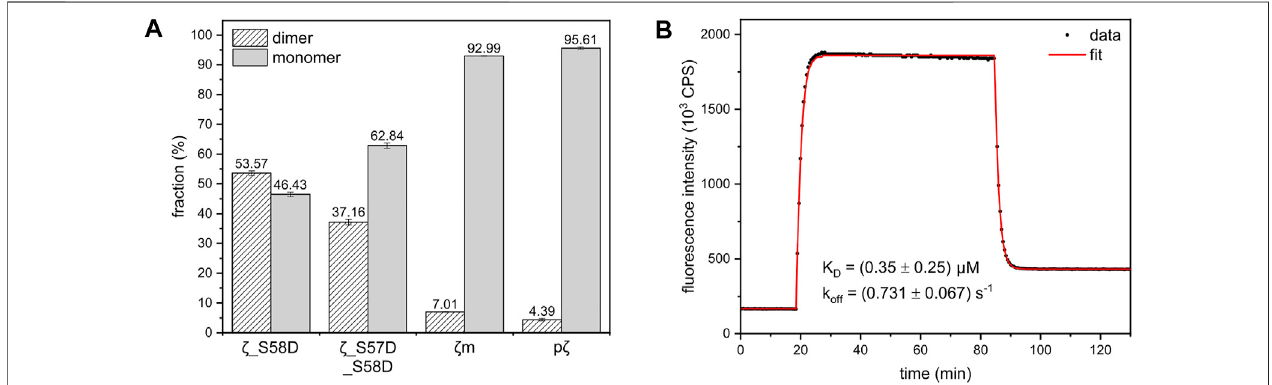
FIGURE 4 | Dimer-monomer distributions and FRETexperiment usedforcalculation ofthe dimerizationK D of 14-3-3 ζ variants. (A) The populations of 14-3-3 ζ proteins ( x -axis)inthedimericand monomericstatedetermined fromSEC-RALSexperiments (SupplementaryFigure S4) asdescribed in thetext. Thedimer-monomerpopulations for 164 μ M ζ _S58Dand ζ _S57D_S58D mutantsand 183 μ M ζ m andp ζ variantsat20 ° Careshown. (B) FRETkineticpro fi leof ζ _S58Edimerization at15 ° C.Theexperimental data (black dots) were fi tted (red line), as in Tro š anová et al. (2022), to obtain K D and k off values.